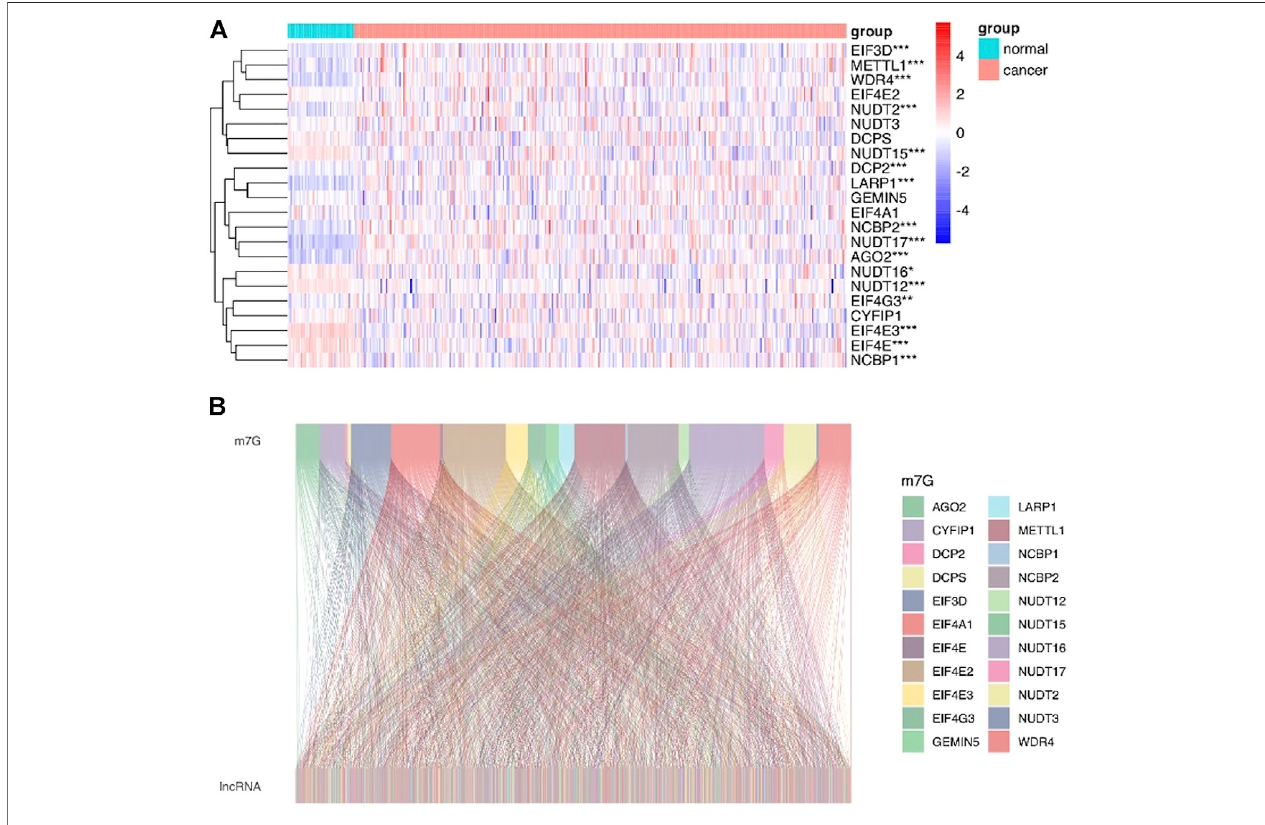
FIGURE 2 | Identi fi cation of m7G-related lncRNAs in LIHC patients. (A) Heatmap showed the differences in the expression of m7G regulators between LIHC and normal groups. (B) Sankey diagram displayed the relationship between 22 m7G genes and 992 m7G-related lncRNAs.